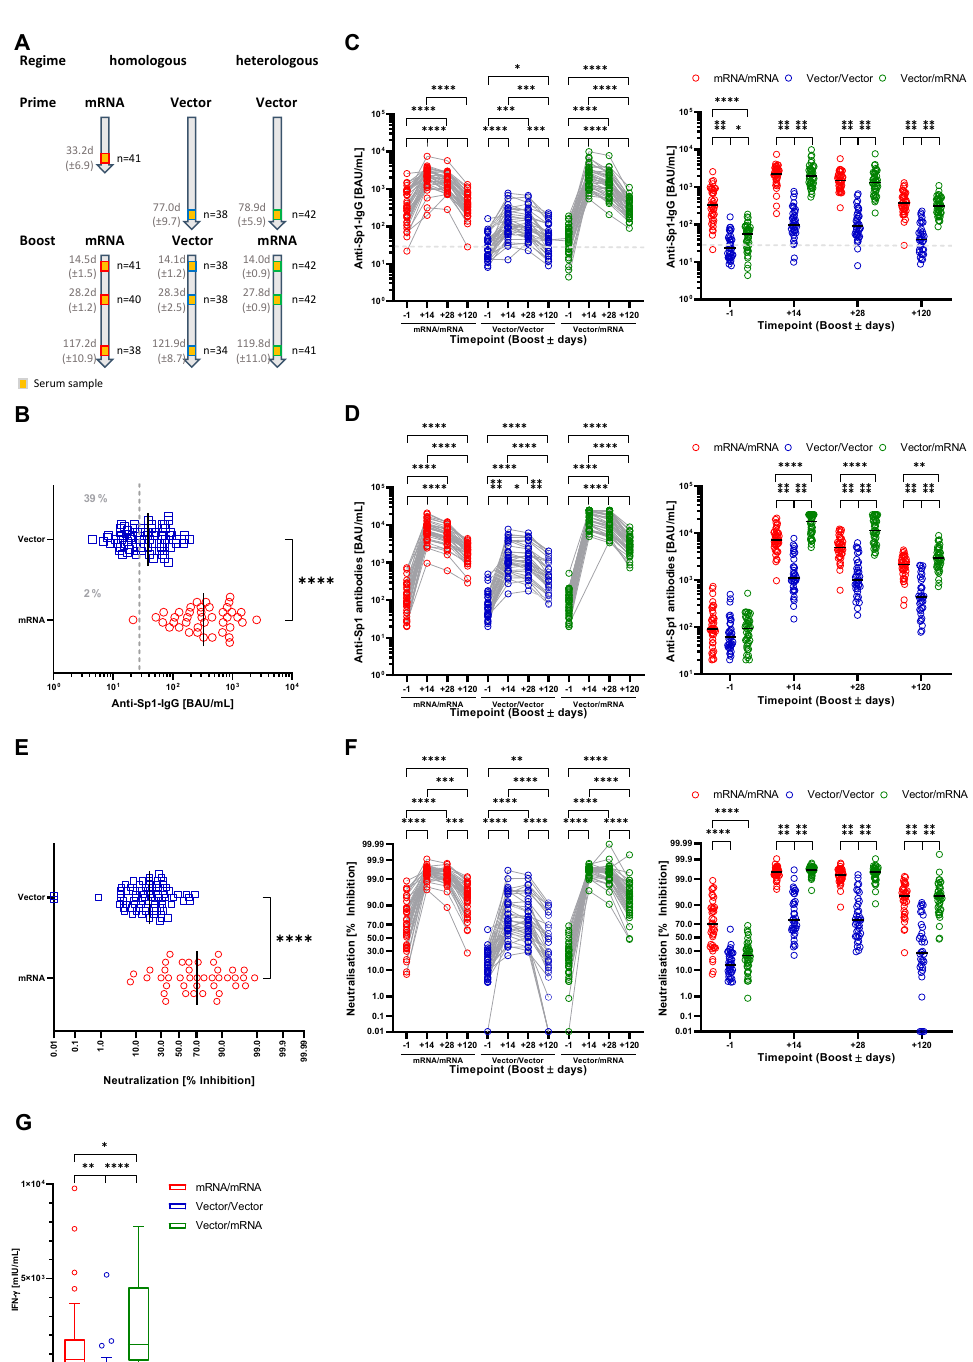
Figure 1. Homologous and heterologous prime-boost immunization regimens induce anti-SARS-CoV- 2 antibody production and immunity. ( A ) Study design and sample generation. Based on the received vaccinations, participants were grouped into the mRNA/mRNA, Vector/Vector or Vector/mRNA group. Serum samples were obtained one day before as well as 14, 28 and 120 days after booster. ( B ) Serum levels of anti-SARS-CoV-2-Sp1-IgG antibodies after vector (blue) or mRNA (red) prime one day before booster vaccination. The dashed line indicates the applied cutoff for positivity. ( C ) Left: Profile of serum anti-SARS-CoV-2-Sp1-IgG antibodies of individual participants based on the different vaccination strategies (red-mRNA/mRNA; blue-Vector/Vector; green-mRNA/Vector). Connected circles represent antibody levels of individual participants. Right: Serum anti-SARS-CoV- 2-Sp1-IgG antibodies according to the study groups at the different time points. ( D ) Left: Profile